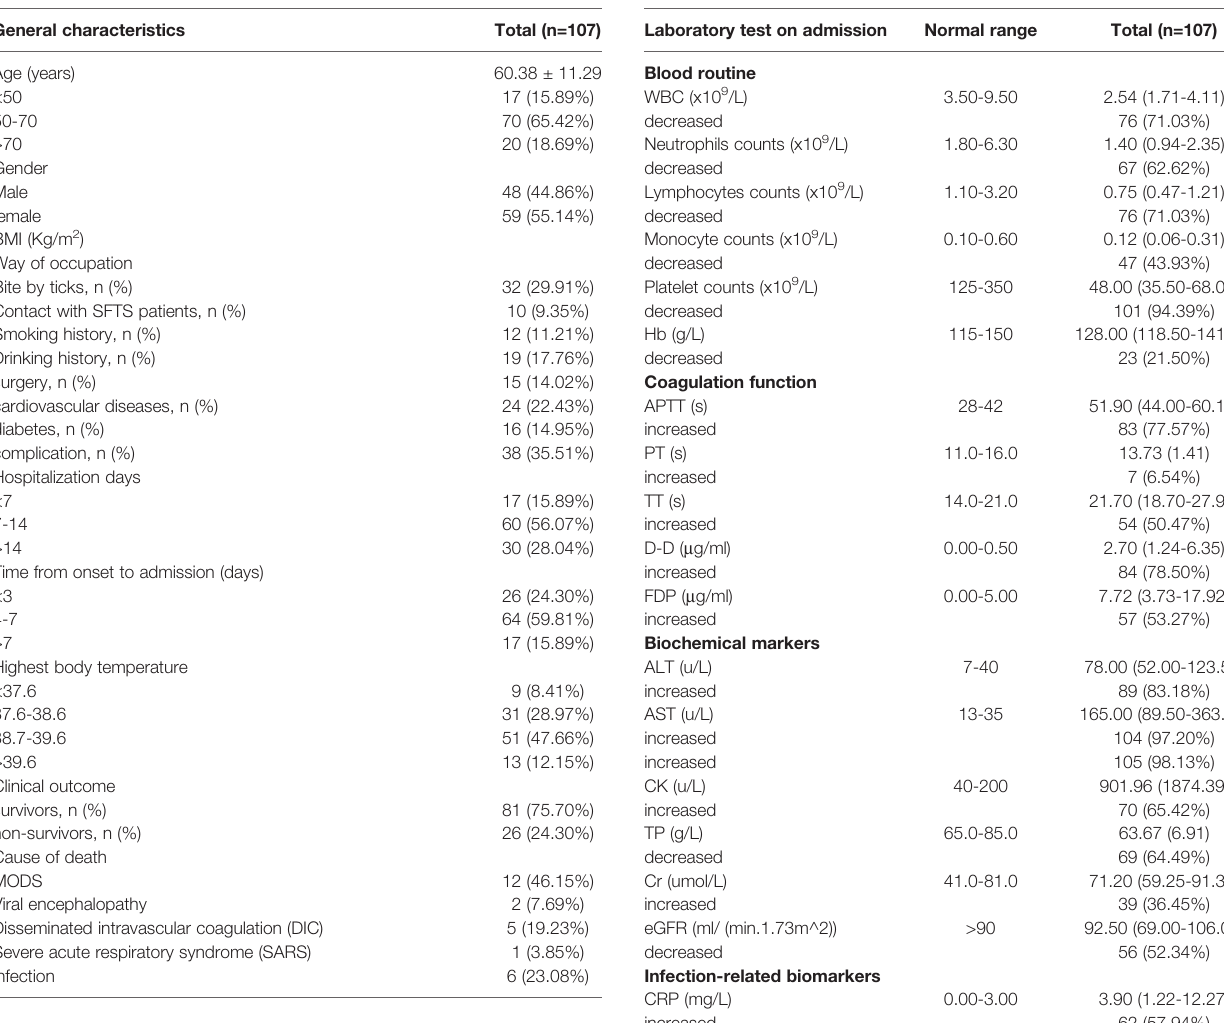
TABLE 2 | Demographics and clinical characteristics of SFTS. TABLE 4 | Laboratory results of SFTS patients at